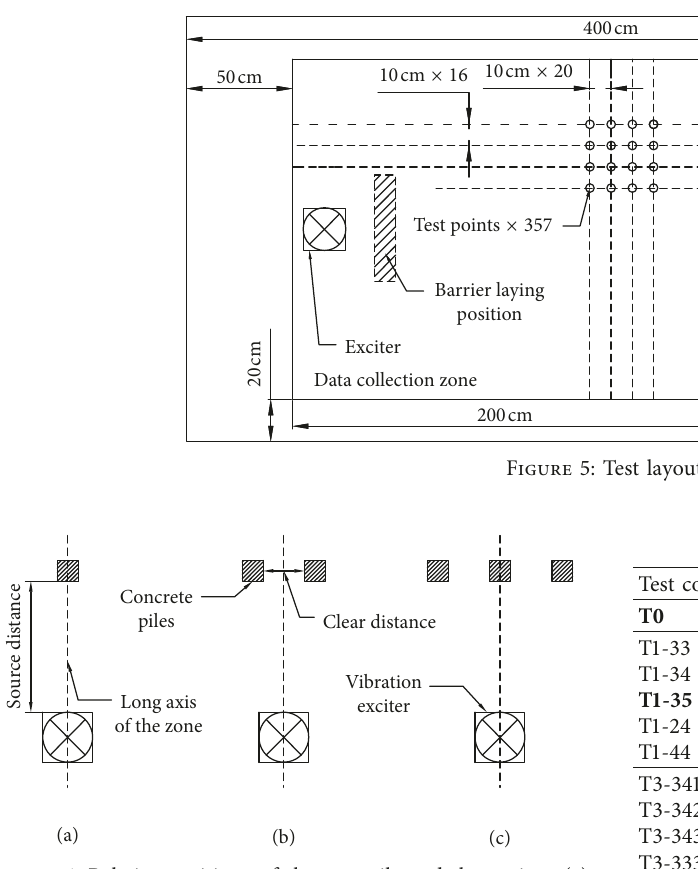
Figure 6: Relative positions of the row pile and the exciter: (a) single pile; (b) double piles; (c) treble piles.